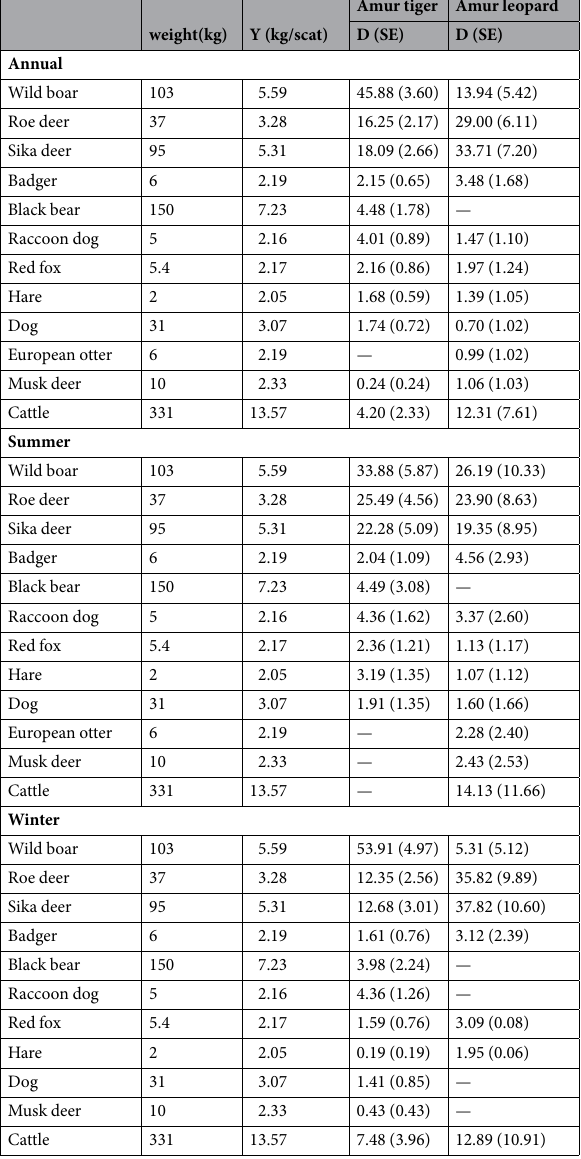
Table 3. Proportion biomass contribution (D) of prey species to Amur tiger and Amur leopard annual and seasonal diets in NE China. Note: Y is the correction factor; The standard error (SE) of each prey item were generated using 10000 bootstrap